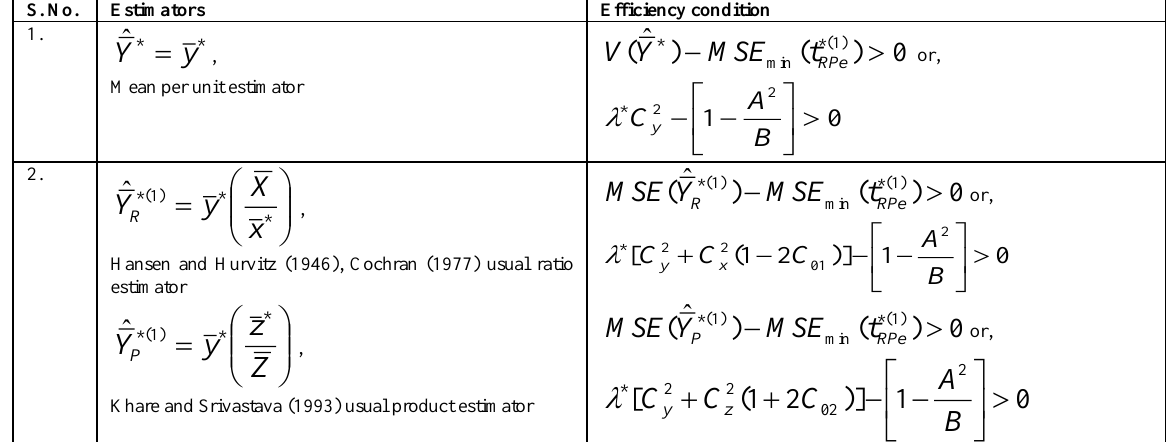
Table 2. Comparison with competing estimators under first strategy of